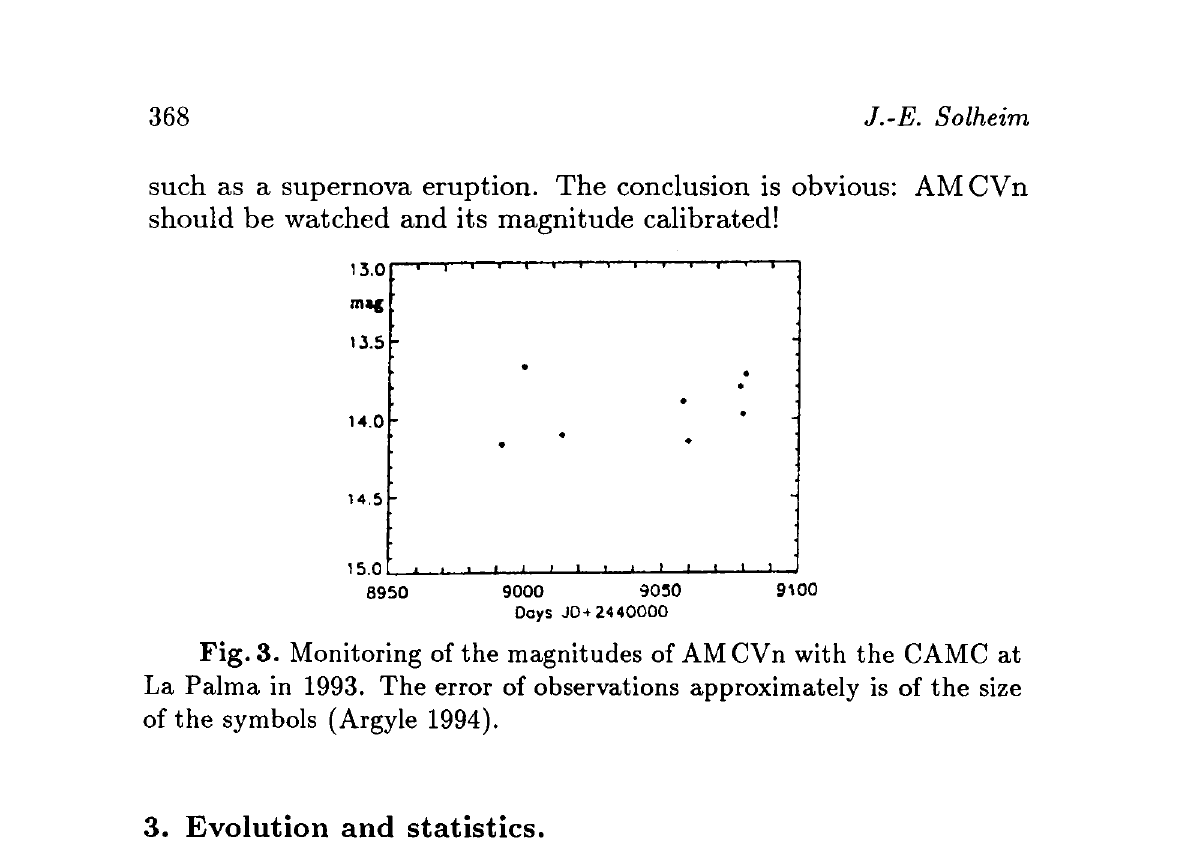
Fig. 3. Monitoring of the magnitudes of AMCVn with the CAMC at La Palma in 1993. The error of observations approximately is of the size of the symbols (Argyle